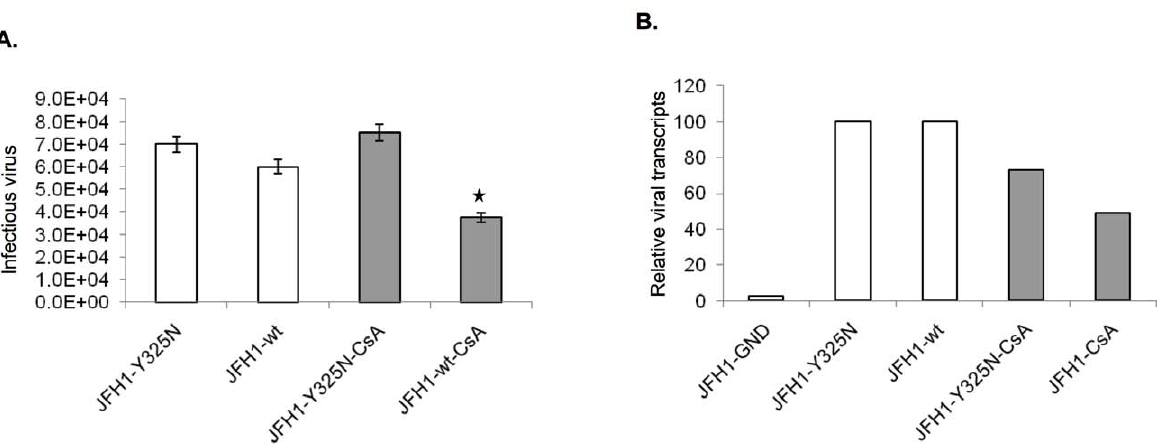
Figure 3. Replication of JFH1 infectious clone carrying a Y325N mutation in the presence and absence of CsA. (A) Infectivity of in vitro- transcribed RNA from JFH1-Y325N and JFH1-wt were determined by infectious center assay. Huh7.5 cells were electroporated with RNA transcripts and cleared supernatant was examined for number of infectious particles by serially diluting and passing on to fresh Huh7.5 cells. The infectious centers were monitored by immunofluorescence assay by using anti-NS5A monoclonal antibodies. Y axis shows number of infectious virus produced. The average of two independent experiments with error bar representing standard deviation is presented. Student’s t test was used to calculate p values. JFH1-wt vs JFH1-wt-CsA, p=0.012, indicated by star. (B) Northern blot analysis of total RNA from either non treated or pretreated Huh7.5 cells electroporated with RNA from JFH1-Y325N and JFH1-wt. Total RNA was isolated from these cells and analyzed by probing with 32 P-labeled random probe derived from C-terminal portion of NS5A. The signal was quantified with Storm and the reading was normalized with respect to actin control. The y axis represents relative transcript levels with JFH1-Y325N arbitrarily set to 100%.